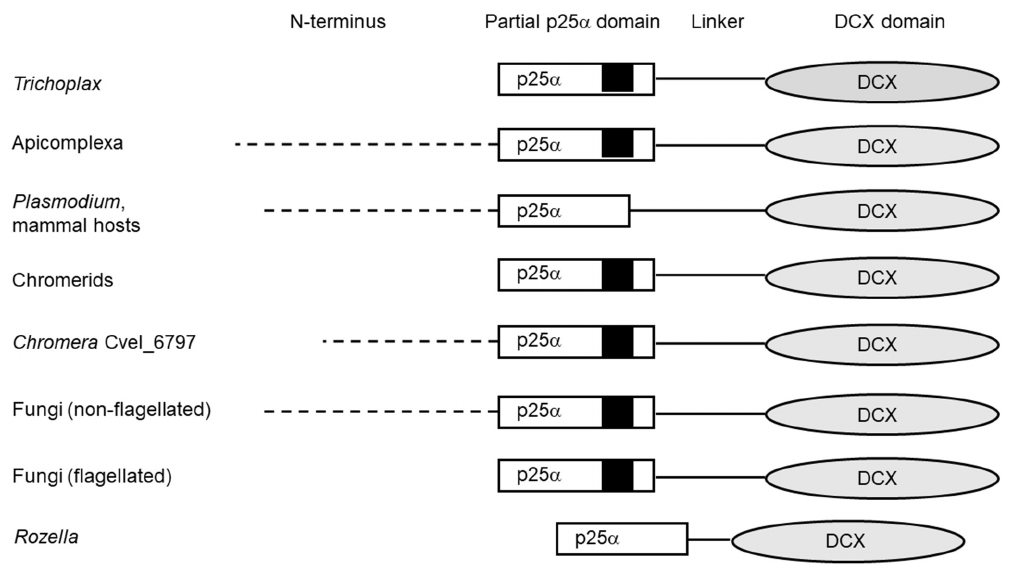
Figure 1. Schematic representation of apicortins. The partial p25alpha and doublecortin (DCX) domains are represented by rectangle and oval, respectively. The positions of the Rossmann-like motif (GXGXGXXGR) are indicated by black squares. The dashed line indicates the long unstructured N-terminus of apicortins.